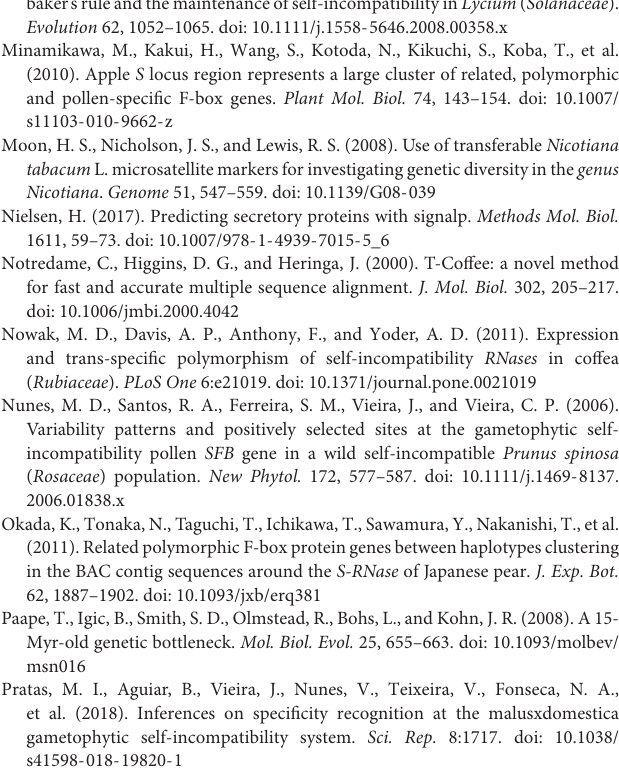
tabacum L.microsatellitemarkersforinvestigatinggeneticdiversityinthe genus Nicotiana . Genome 51, 547–559. doi: